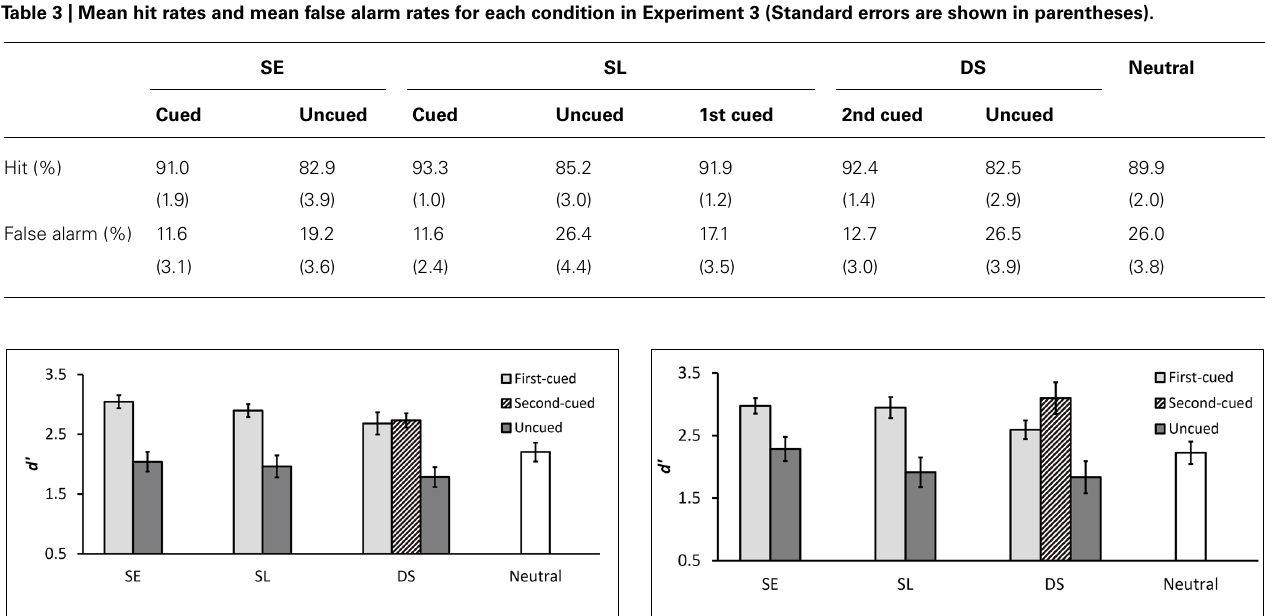
FIGURE 6 | Mean d (cid:2) for each cue type condition in Experiment 3. Error bars represent standard errors.